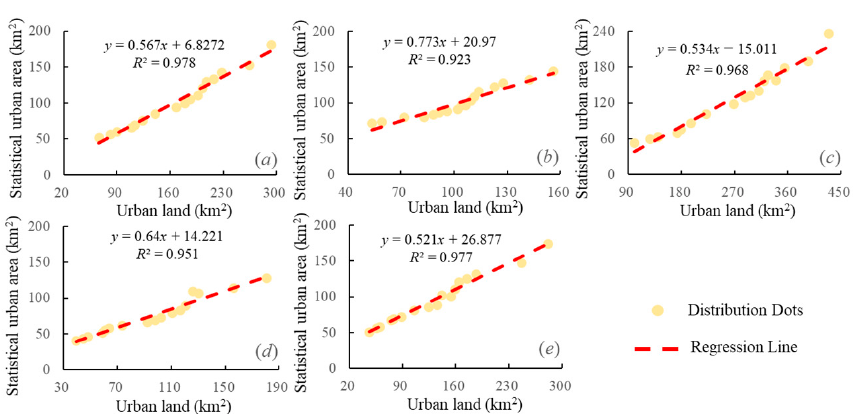
Figure 5. Regression analysis between Urban land data and Statistical urban area. All cities ( a ), NER ( b ), ER ( c ), CR ( d ), and WR ( e ).